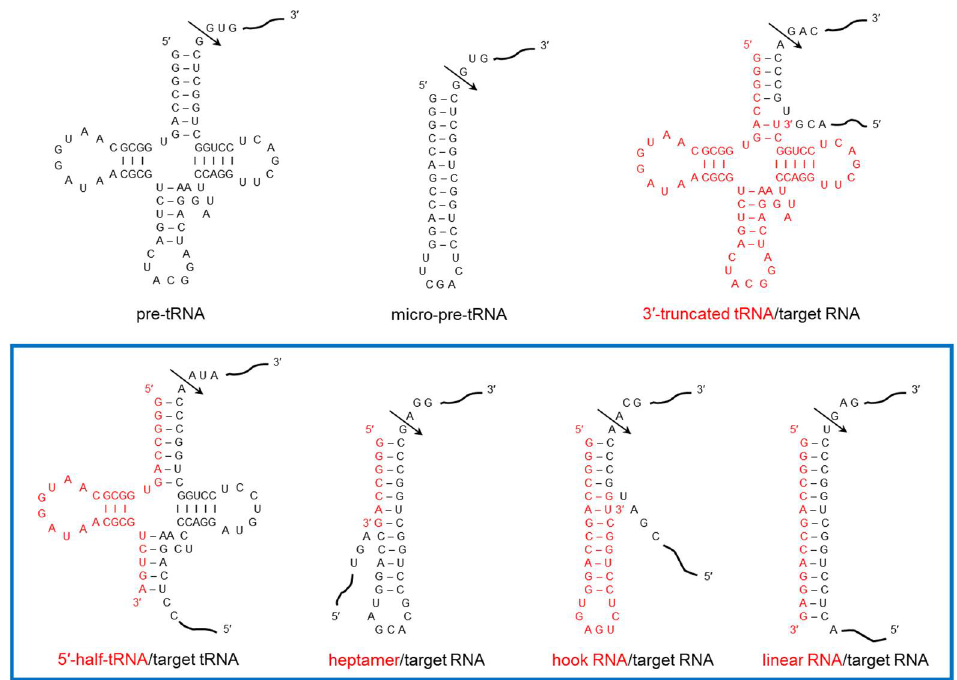
Figure 1. Substrates of tRNase Z L . The RNA complexes of the four types of sgRNA and their target RNAs are shown in a blue box. Arrows denote cleavage sites by tRNase Z L .